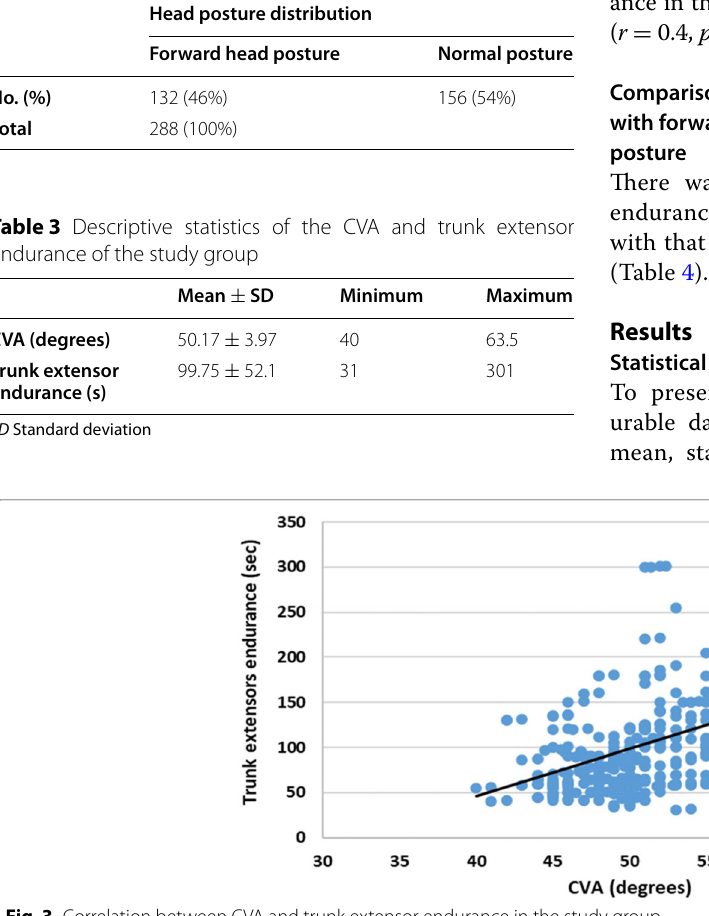
Table 4 Comparison of trunk extensor endurance between children with forward head posture (FHP) and children with normal posture